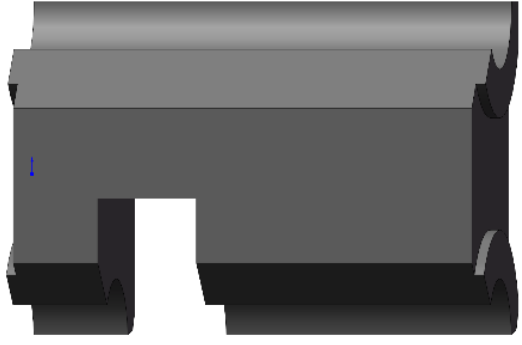
Figure 6. Solid drive rod model.